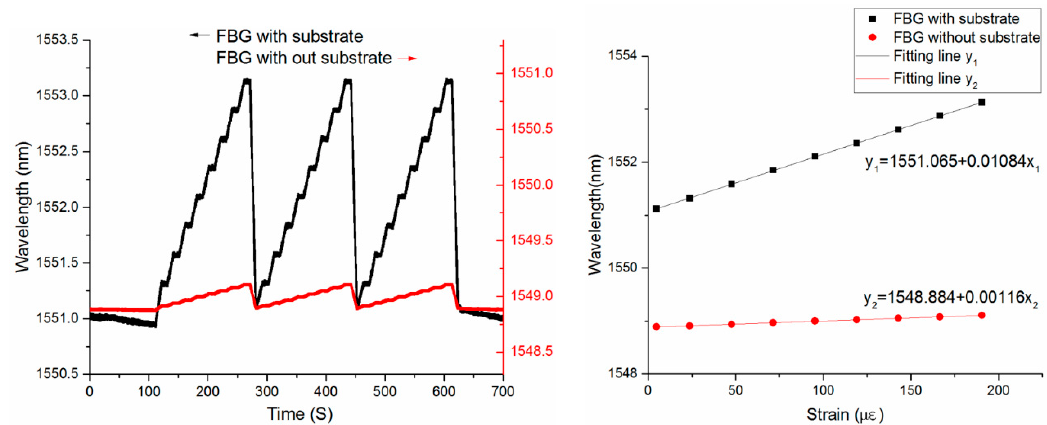
Figure 10. The experiment results. Left: Strain calibration curve; Right: Fitting curve of sensitivity.